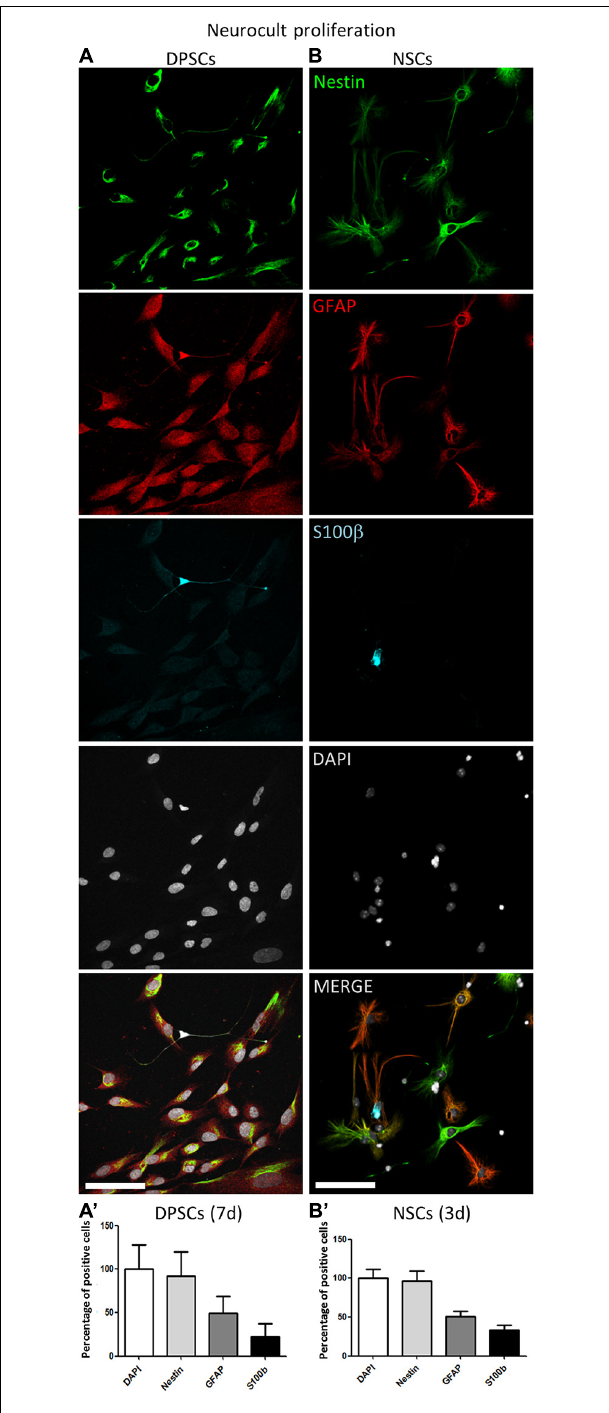
FIGURE 2 | Human DPSCs grown in Neurocult proliferation share neural stem/progenitor markers with murine NSCs. (A,A’) Human DPSCs were allowed to grow for 7 days in laminin-coated wells in the presence of Neurocult proliferation media are Nestin positive and also express astroglial markers GFAP and S100ß ( n = 230). (B,B’) Murine NSCs grown for 3 days (to avoid confluency) in the same culture conditions also express these astroglial markers in similar proportion ( n = 242). Mean ± SEM of three independent experiments. Scale bar 75 µ